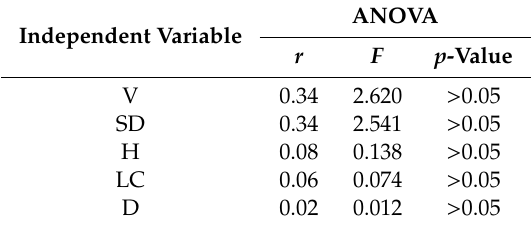
Table 7. Linear regression analysis of the WT consumed for felling of hung-up trees in relation to DBH. ANOVA Significance of Variable Coe ffi cient Standard Standard Degrees of t Statistic p –value F Variable Coe ffi cient R 2 Error Error freedom Simple linear regression analysis of WT in relation to DBH Constant 1452.042 196.399 7.393 - Regression 1 0.19 122.668 4.580 * DBH − 12.555 5.866 − 2.140 < 0.05 * Residual 20